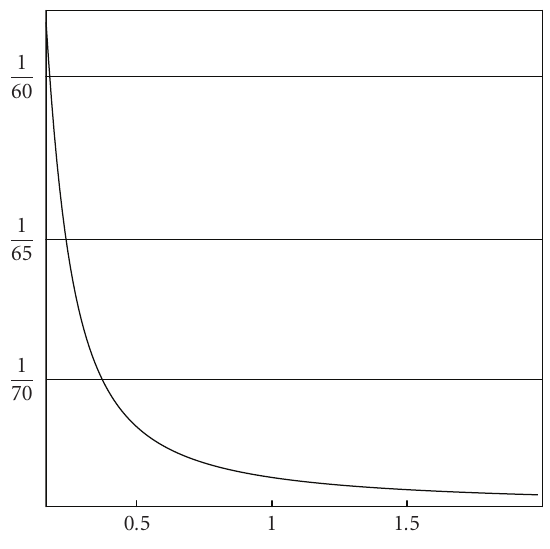
Figure 4.1. The quantity p/q = (1 / 2 π )arccos a , as a function of β , on the bifurcation